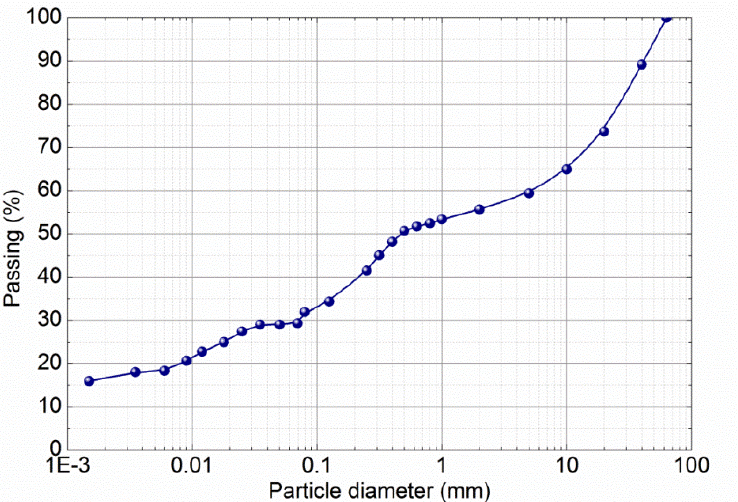
Figure 2. Particle-size